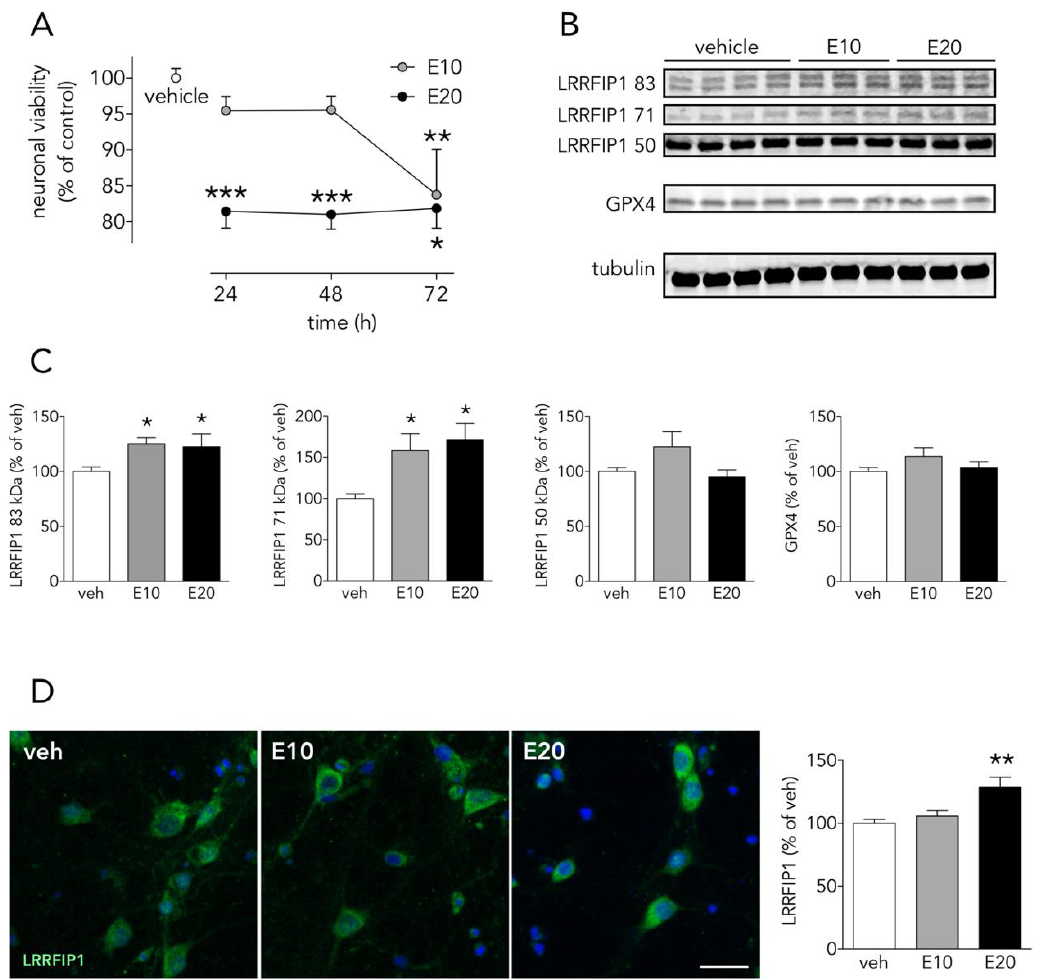
Figure 8. The ferroptosis inducer erastin increases neuronal LRRFIP1 levels. ( A ) Time-course effect of erastin on neuronal viability in vitro (one-way ANOVAs plus SNK, n = 3 independent primary neuron culture preparations, with 3 technical replicates each). ( B ) WB showing the effect of erastin on LRRFIP1 and GXP4 levels at 24 h, and ( C ) graphs depicting the quantification of this effect (one-way ANOVA plus SNK, n = 3 independent primary neuron culture preparations, with 3 technical replicates each). ( D ) Representative ICC images showing LRRFIP1 expression in neurons exposed to vehicle (veh) or erastin for 24 h, and a graph showing the quantification of this effect. Ten µM erastin: filled grey circles/bars or E10; 20 µM erastin: filled black circles/bars or E20. Results are shown as the mean and SEM. * p < 0.05, ** p < 0.01, *** p < 0.001 vs. vehicle in all graphs. Scale bar: 20 µm.